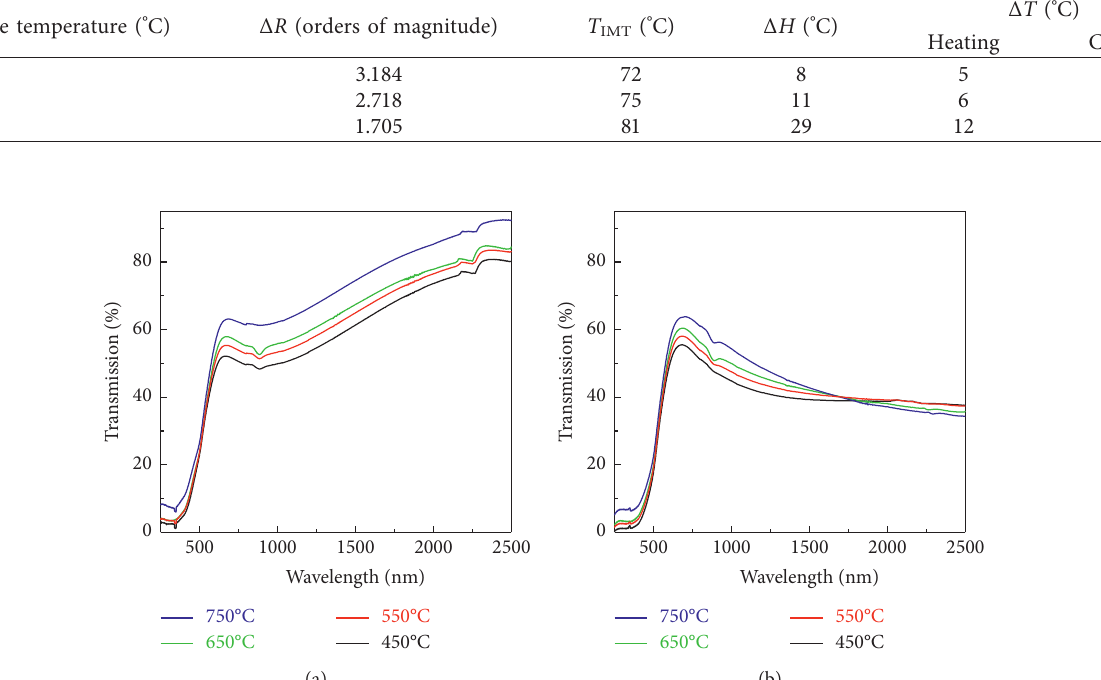
Figure 6: Spectral transmittance at room temperature (a) and at 90 ° C (b) of PLD VO